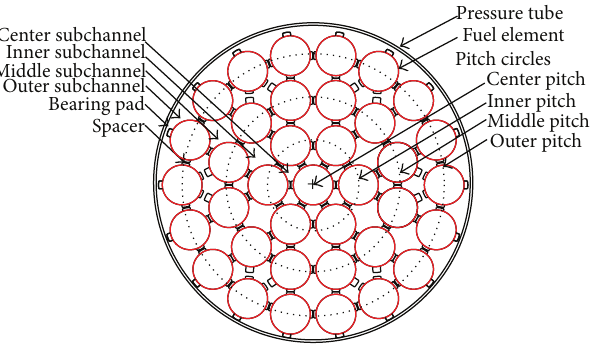
Figure 1: Cross-sectional view of a 37S fuel bundle.